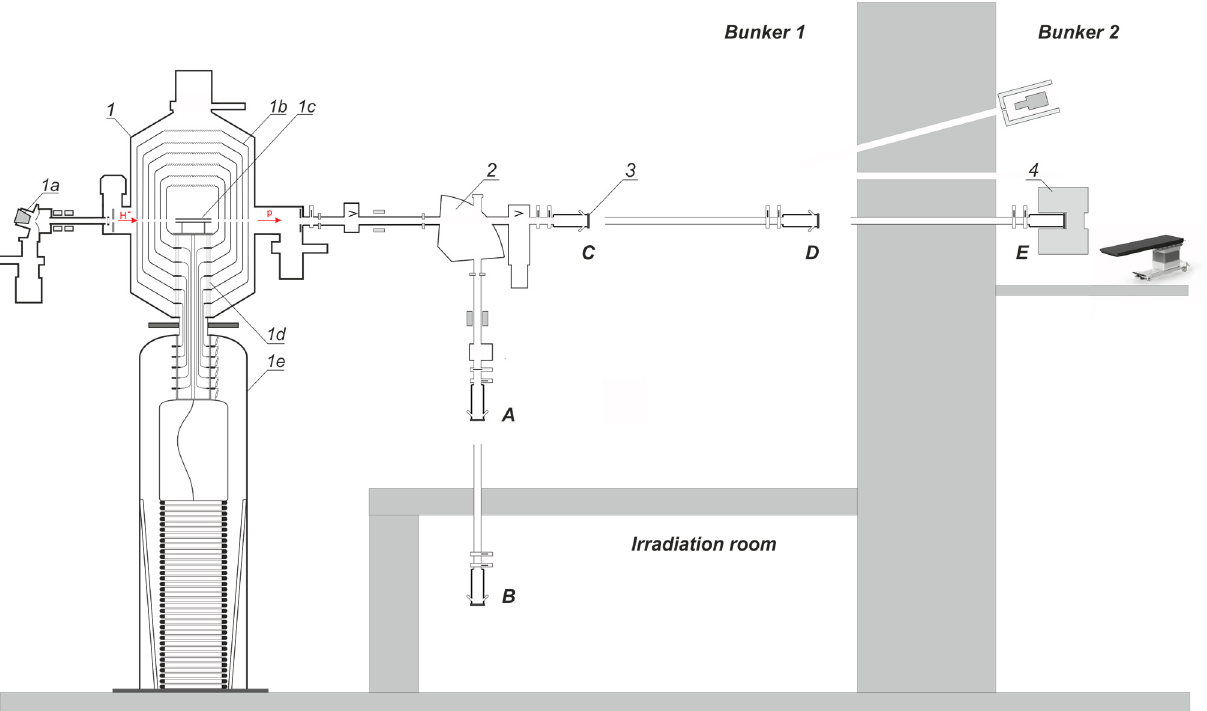
Figure 1. Layout of the experimental facility: 1 —vacuum-insulated tandem accelerator ( 1a —negative ion source, 1b —intermediate- and high-voltage electrodes, 1c —gas stripper, 1d —feedthrough insulator, 1e —high-voltage power supply), 2 —bending magnet, 3 —lithium target, 4 —beam-shaping assembly. A , B , C , D , E —lithium target placement positions.